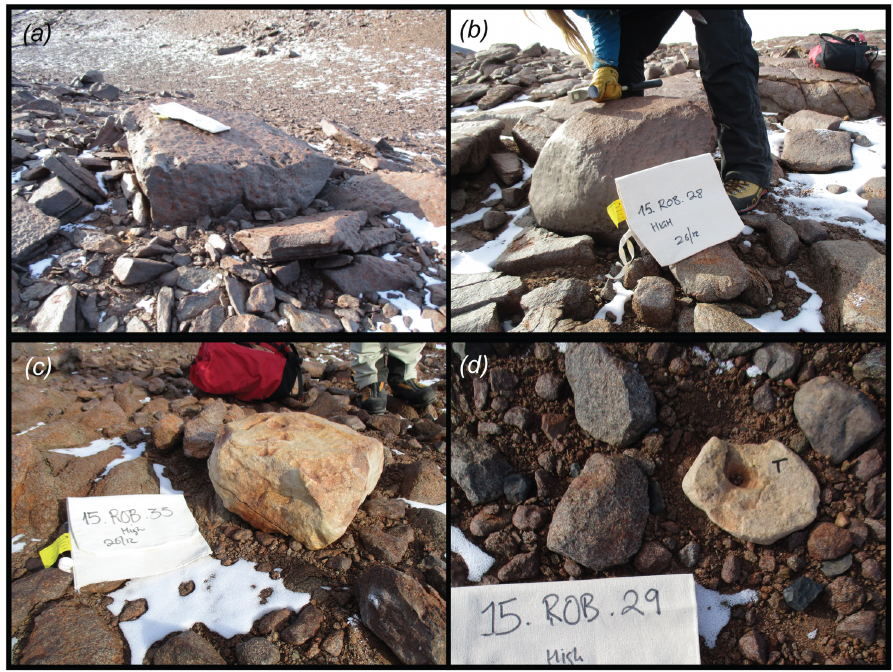
Figure 9. Photographs of boulders from the Misery Platform. (a) dolerite boulder 15-ROB-017-MZC on the Misery C moraine; (b) Dolerite boulder 15-ROB-028-COL at the Southwest Col; (c) sandstone boulder 15-ROB-035-COL at the Southwest Col; (d) Sandstone cobble 15-ROB-029-COL at the Southwest